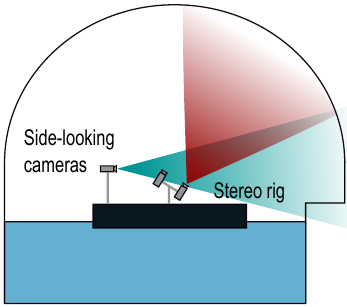
Figure 8: Camera configuration used for modeling the tunnel by